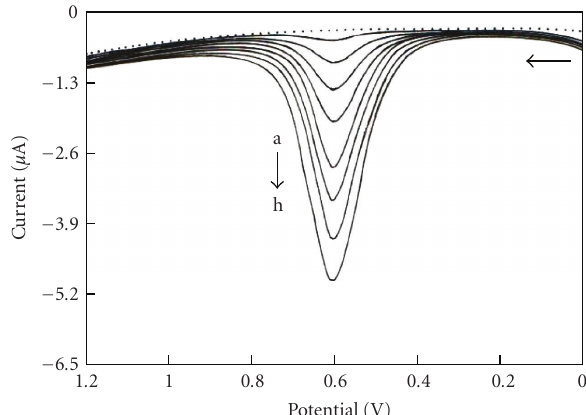
Figure 5: Square wave voltammograms of various concentrations of salbutamol at SWNT-modified EPPGE in 1M phosphate bu ff er (pH 7.2); [salbutamol]: a = 50, b = 250, c = 500, d = 750, e = 1250, f = 1500, g = 1750, h = 2000 ng/mL.